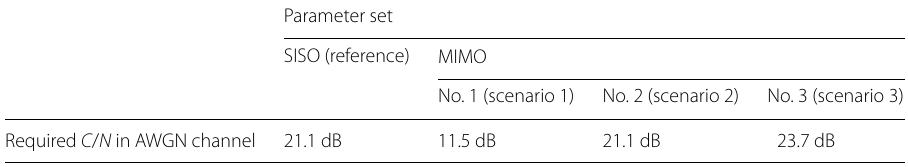
Table 5 Required C / N in laboratory experiments